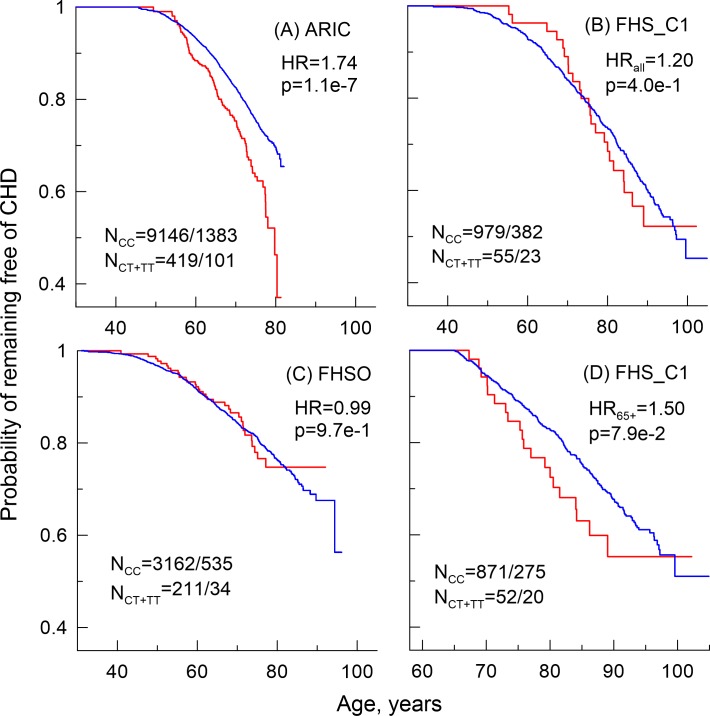
Probability of remaining free of coronary heart disease (CHD) for the rs222826_T allele carriers.(A) The Atherosclerosis Risk in Communities Study (ARIC), (B, D) the Framingham Heart Study (FHS) original (FHS_C1) cohort, (C) the FHS Offspring (FHSO) cohort. HR denotes hazard ratio, HRall in panel (B) denotes the estimates for the entire FHS_C1 sample. HR65+ in (D) denotes the estimates for onsets of CHD at ages 65 years and older. N = n/m denotes the size of the entire sample (n) and the number of CHD cases (m) for major allele homozygotes (CC, blue color) and minor allele carriers (CT+TT, red color). P shows p-values.